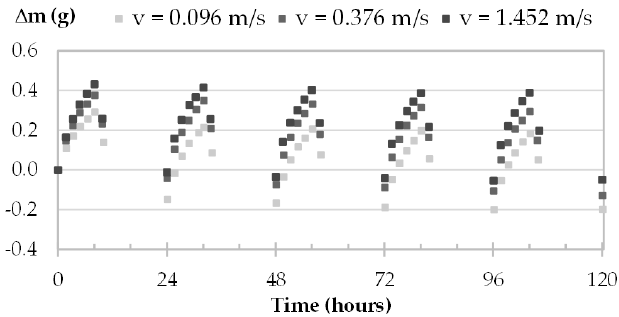
Figure 9. Moisture uptake and release kinetics for one specimen of CC (CC-c-1) in tests 1-2-3.